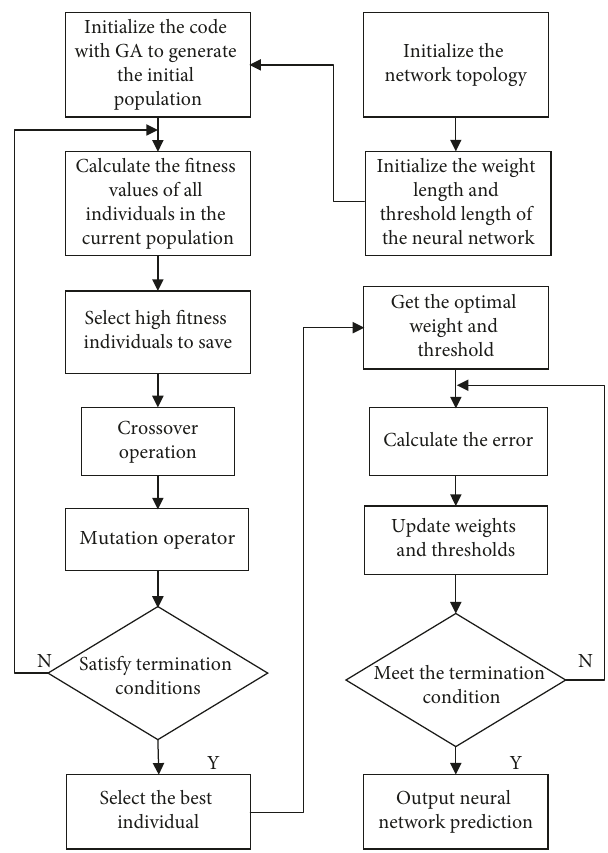
Figure 2: BP neural network optimization by the genetic algorithm.